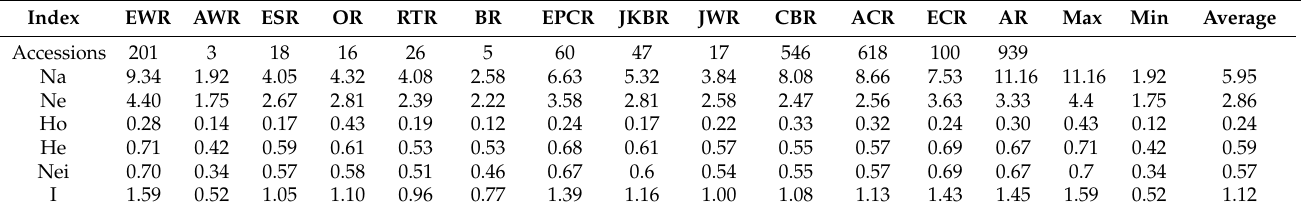
Table 1. Genetic diversity estimates within different wild and cultivated radish populations.